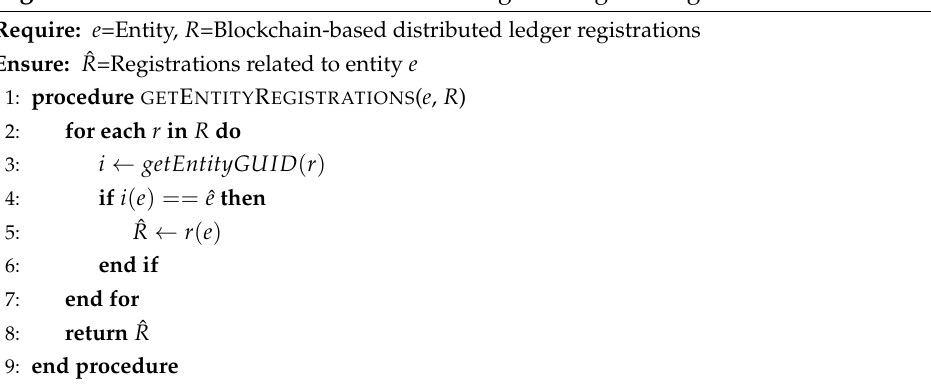
Algorithm 1 Blockchain-based distributed ledger data gathering.